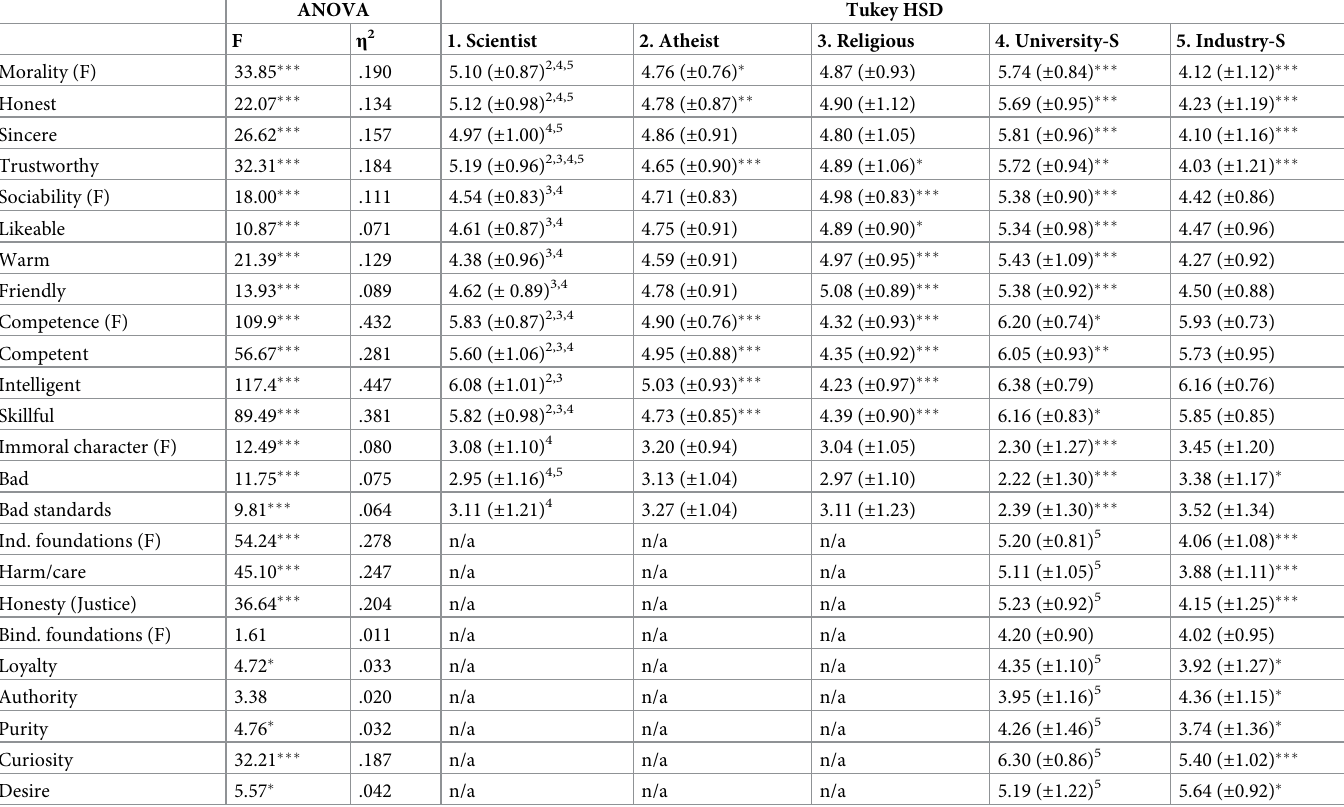
Table 1. Means and standard deviations for all groups and results of ANOVA and Tukey HSD